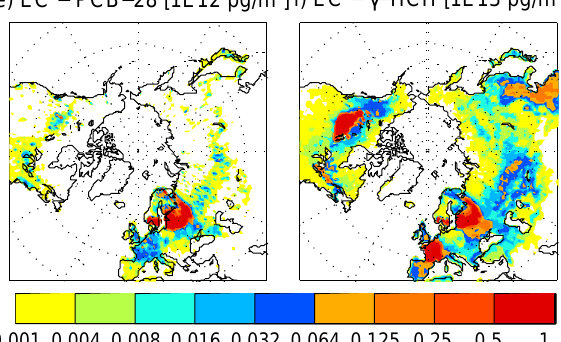
Fig. 4. Model results for the case study of a measurement sample taken at Birkenes from 7–8 June 2007: (a) Mean retroplume trajec- tory, with the grey line indicating the retroplume mean trajectory and black dots marking daily intervals. (b) emission sensitivities (ES) in the footprint layer for a passive tracer experiencing no re- moval processes; (c) same as (b) but for simulated PCB-28, and (d) ES for simulated γ -HCH. (e) Emission contributions (EC) for simulated PCB-28 and (f) for simulated γ